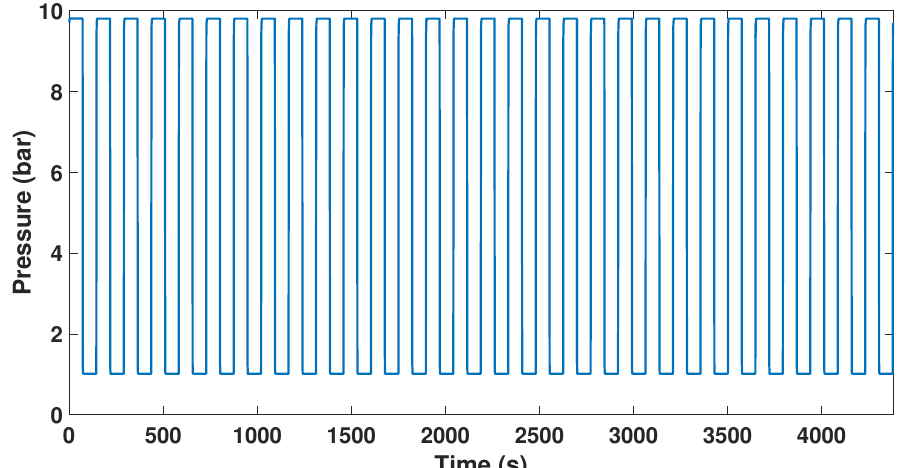
Figure 3. Pressure profiles as a function of time obtained from the start-up of the PSA process until reaching the